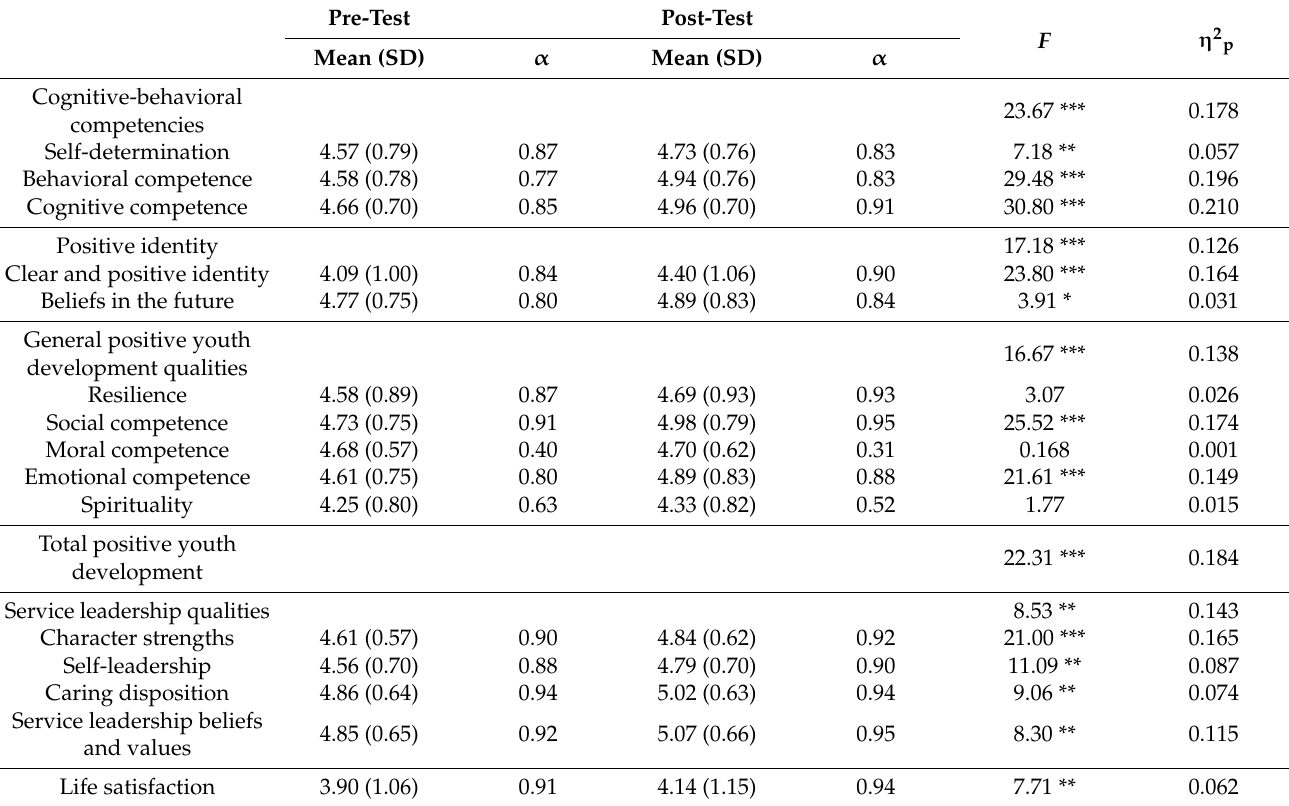
Table 2. Outcome changes between pre-test and post-test from the Objective Outcome Evaluation Form by university students (service providers) ( n =